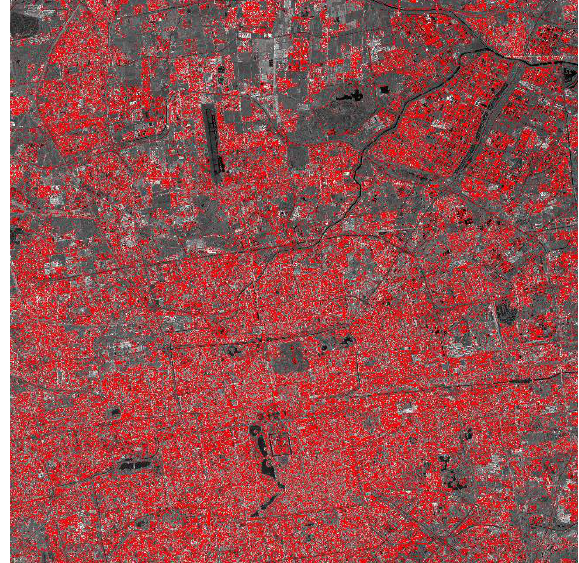
Figure 4. Distribution map of the initial candidate